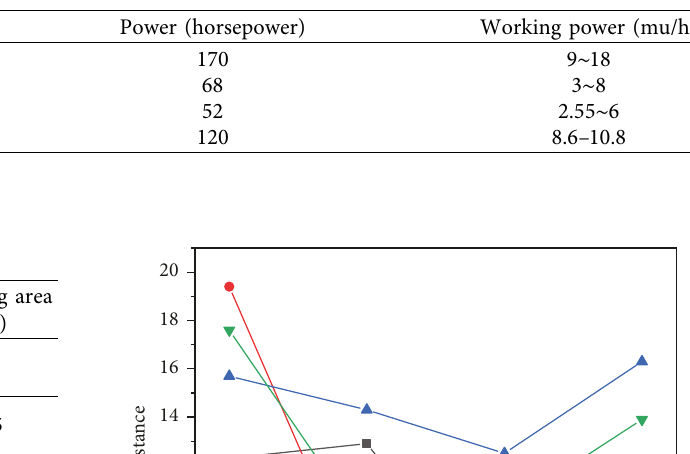
Table 3: Harvester information sheet.